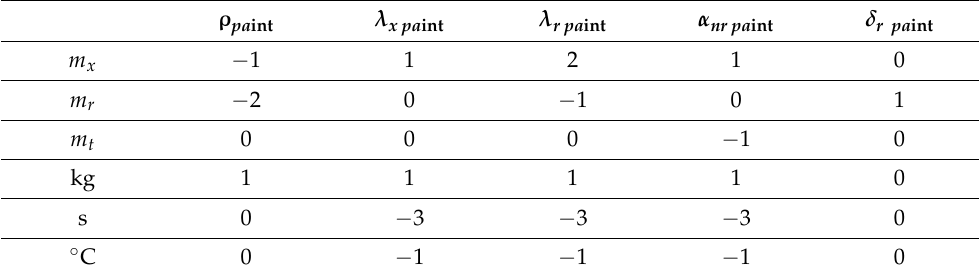
Table 11. The properties of the intumescent paint (part of matrix B).